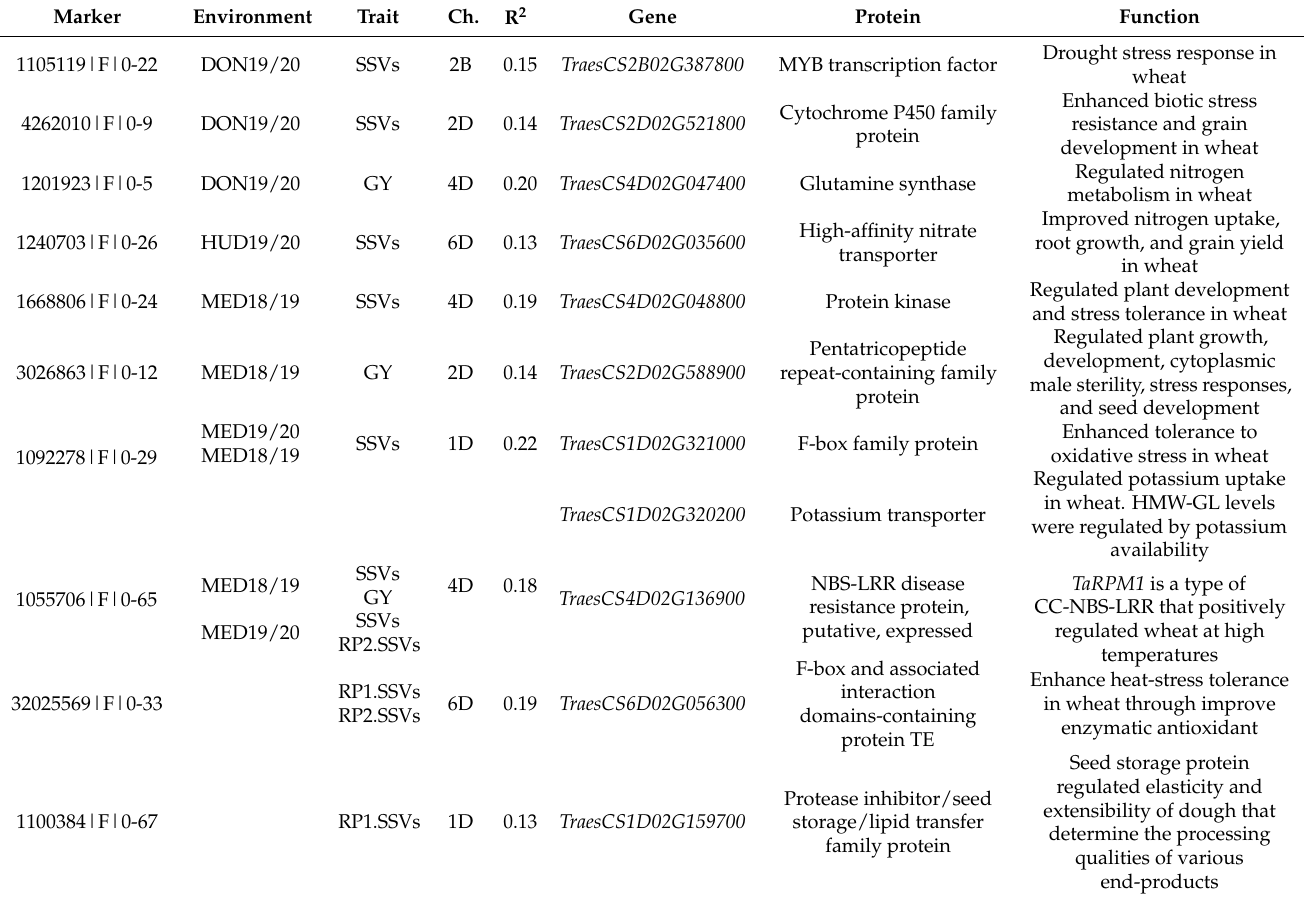
Table 3. Candidate genes for strong marker–trait associations identified for grain yield, dough strength, and relative performance calculated for dough strength under different